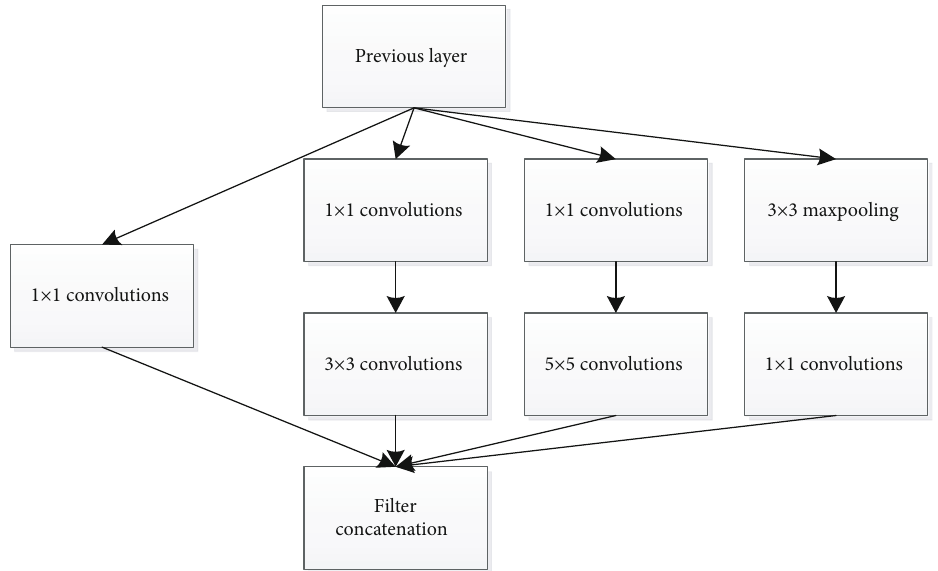
Figure 3: Inception structure.